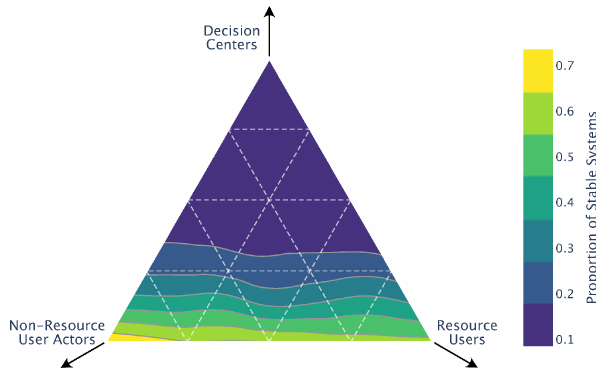
Figure 4. Effect of the number of resource users, non-government organizations, and decision centers on stability. The color represents the proportion of stable systems for a given system composition. The total system size is 10, with a minimum of two resource users and one decision